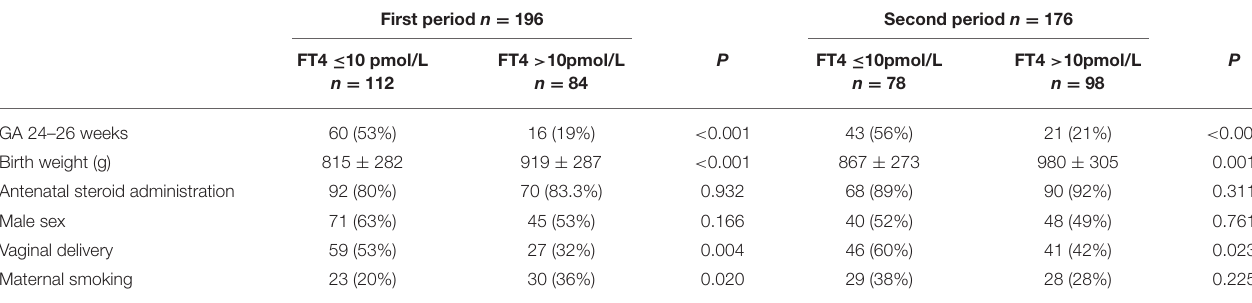
TABLE 2 | Perinatal factors associated with the threshold value of FT4 10 pmol/L in preterm infants born in the two time periods.